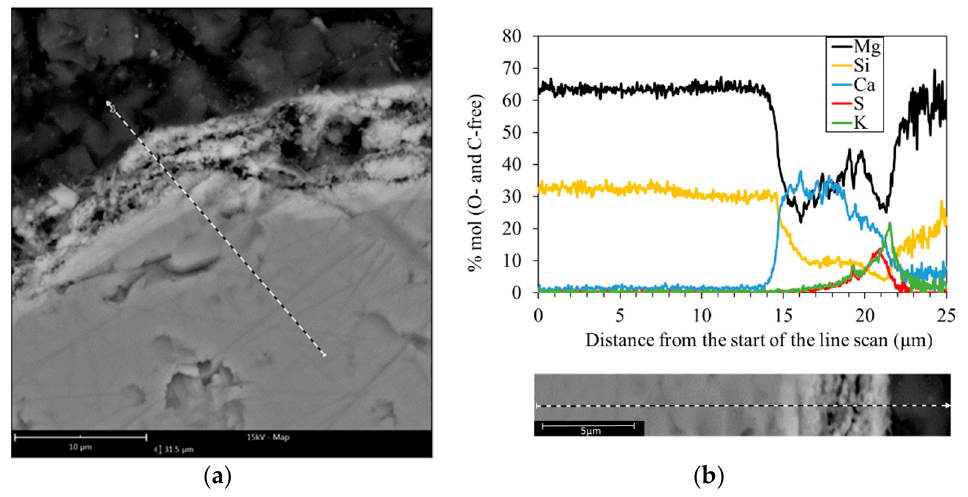
Figure 4. Line scan of the ash layer of an olivine particle. Sample taken at loop seal 1 (inlet to the gasifier) after the addition of elemental S to the boiler. ( a ) SEM image with the indicated location of the selected line; the length of the analyzed line is 25 µm. ( b ) EDX analysis of the selected line. The line scan starts inside the particle and proceeds outwards.